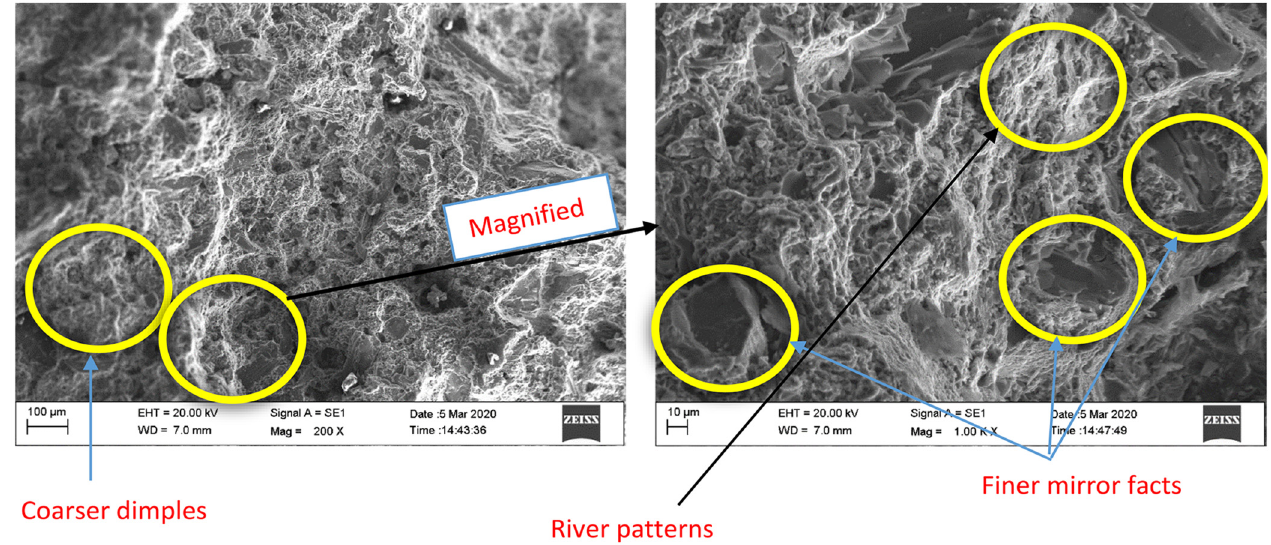
Fig. 15. SEM micrographs of fractured S3 composite (peak